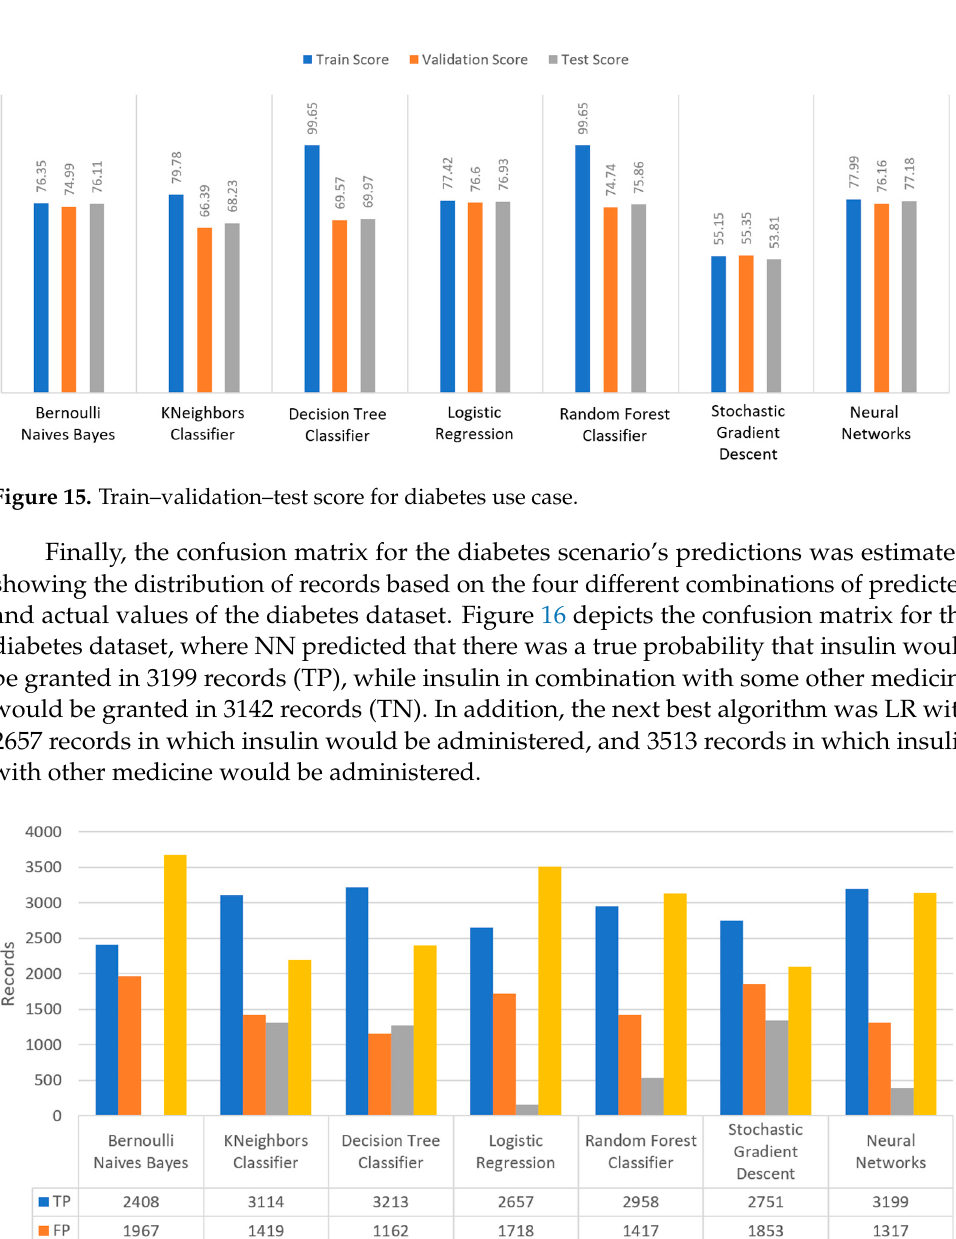
26 of 46 Figure 14. Specificity results of ML models for each use case. 3.3.1. Diabetes Use Case Apart from the abovementioned metrics, the train, validation, and test scores were used for the models’ evaluation, as described in Section 2.2. For the diabetes dataset, in Figure 15, DT and RF achieved a train score percentage equal to 99.65%, while the rest of the algorithms achieved a score under 80%. Moreover, it was observed that BNB (76.35%) or KNN (79.78%) could not be properly trained, due to the training data. As for the vali-